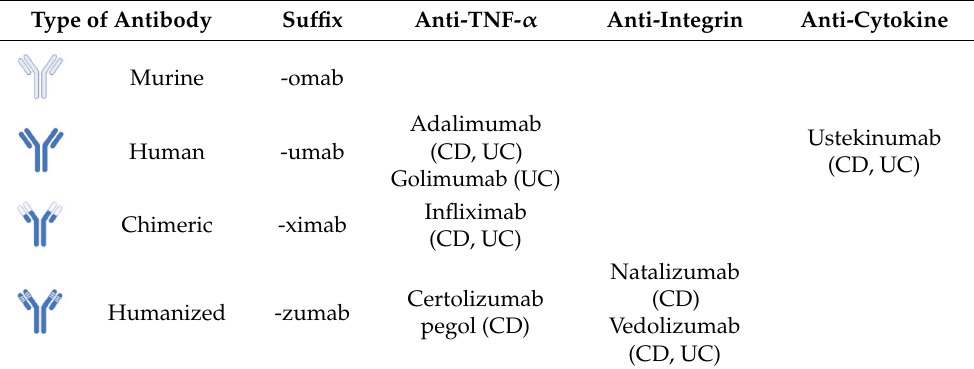
Table 1. Main biologics (monoclonal antibodies) approved for IBD treatment. Type of